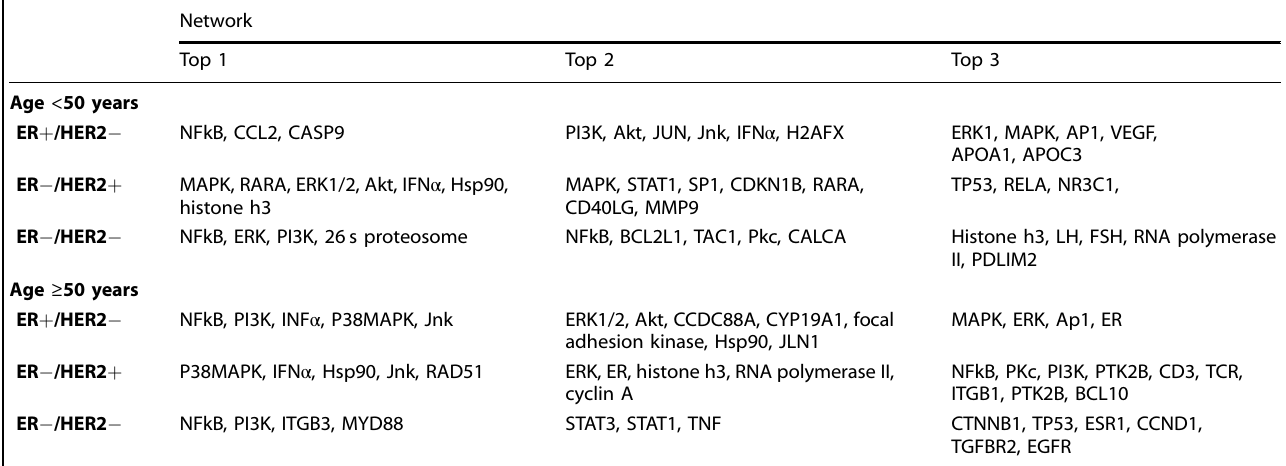
Table 1. Three major networks of overlapping differences in GE and CNV in NTUH and METABRIC